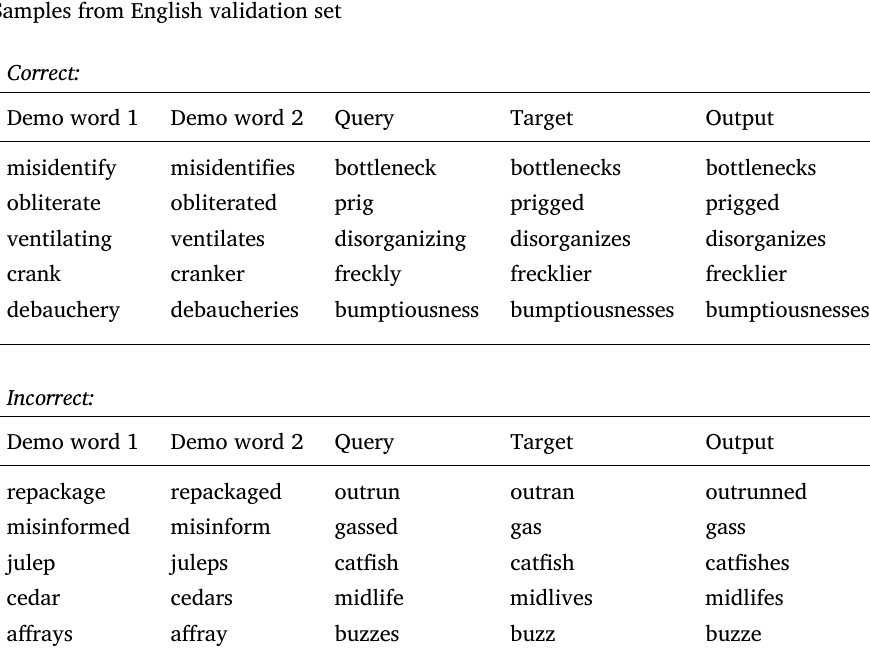
Table 7: Correct (top), and incorrect (bottom) example outputs from the model. Samples from English validation